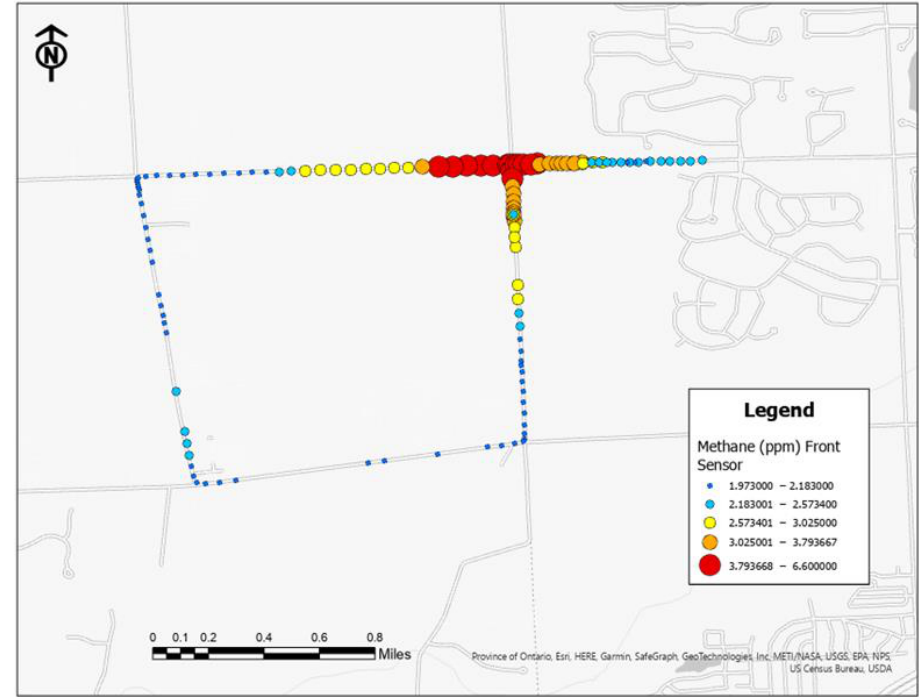
Figure 6. CH 4 concentrations (ppm) measured by MPAL on 5 June 2021, 10:24 a.m. to 10:39 a.m.